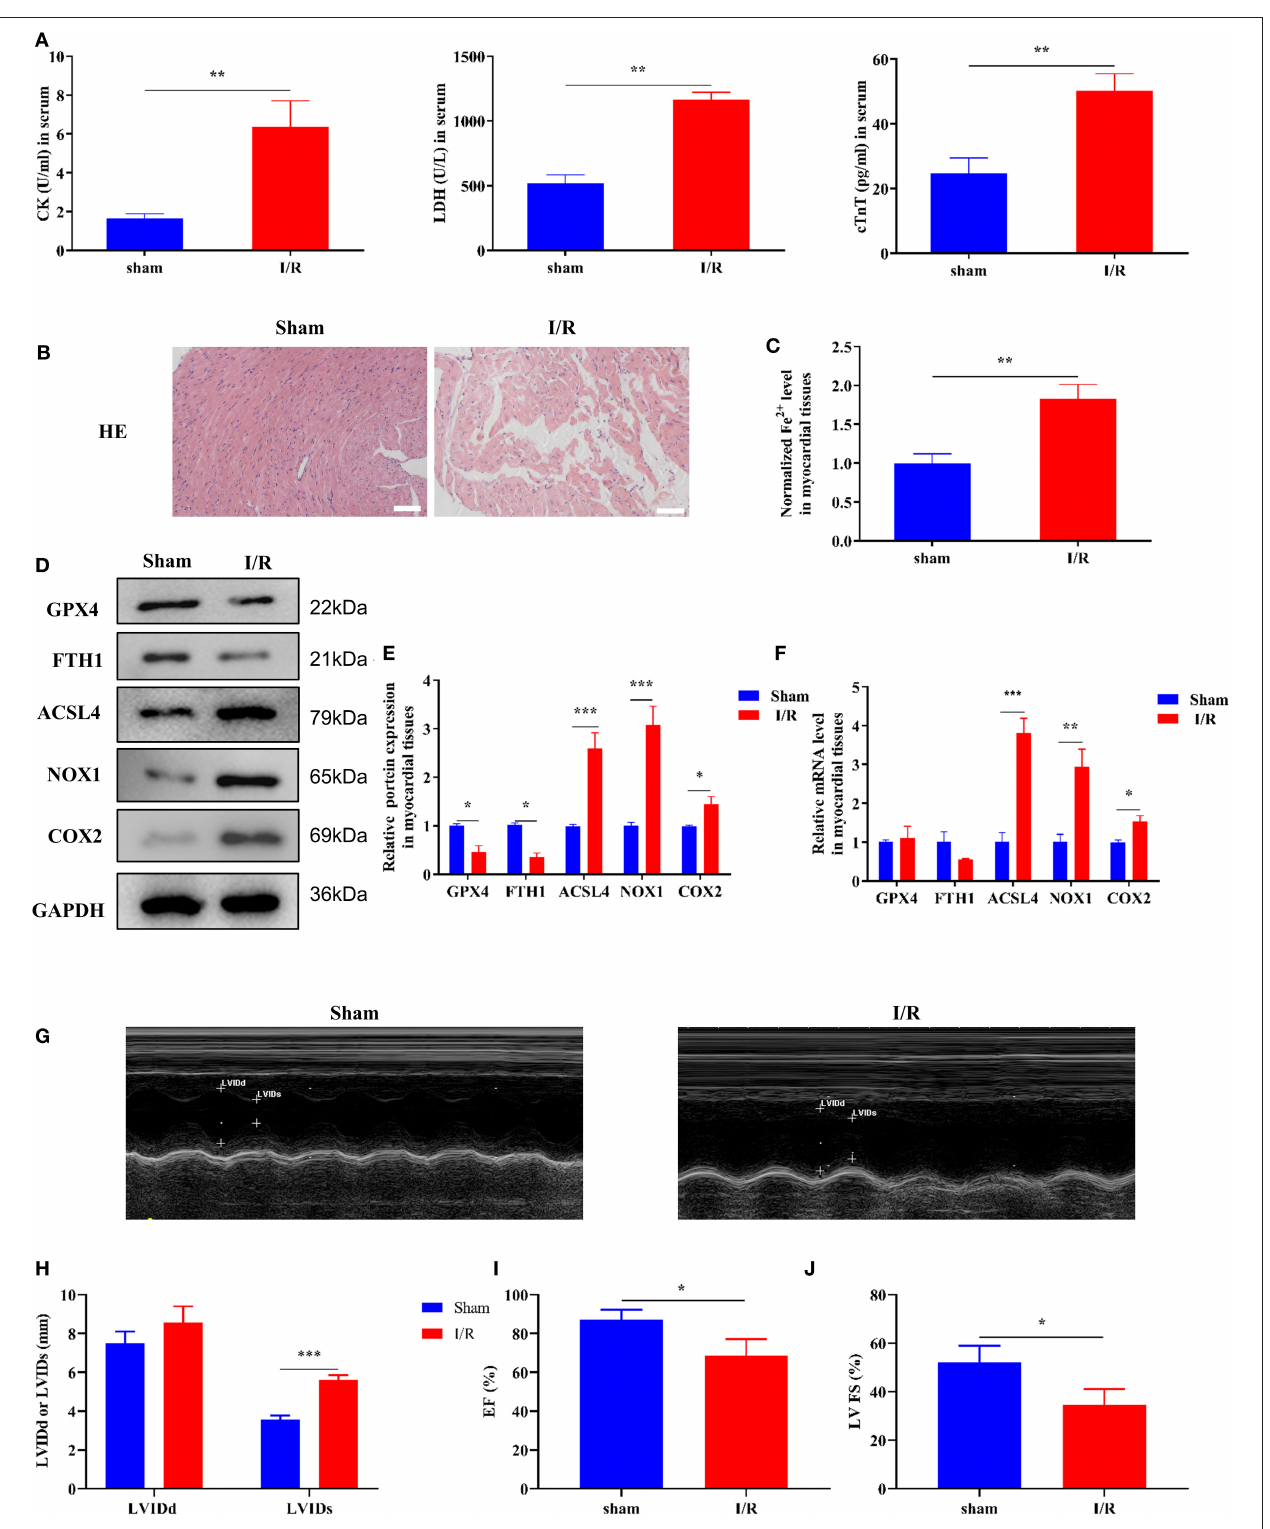
FIGURE 1 | Ferroptosis occurs in myocardial I/R rats. This part of the study was based on sham and I/R rats ( n = 6). (A) The concentration of CK, LDH, and cTnT in serum was determined using ELISA. (B) HE staining was performed to detect myocardial tissue injury. Scale bar = 50 µ m. (C) Iron assay kit was used to measure